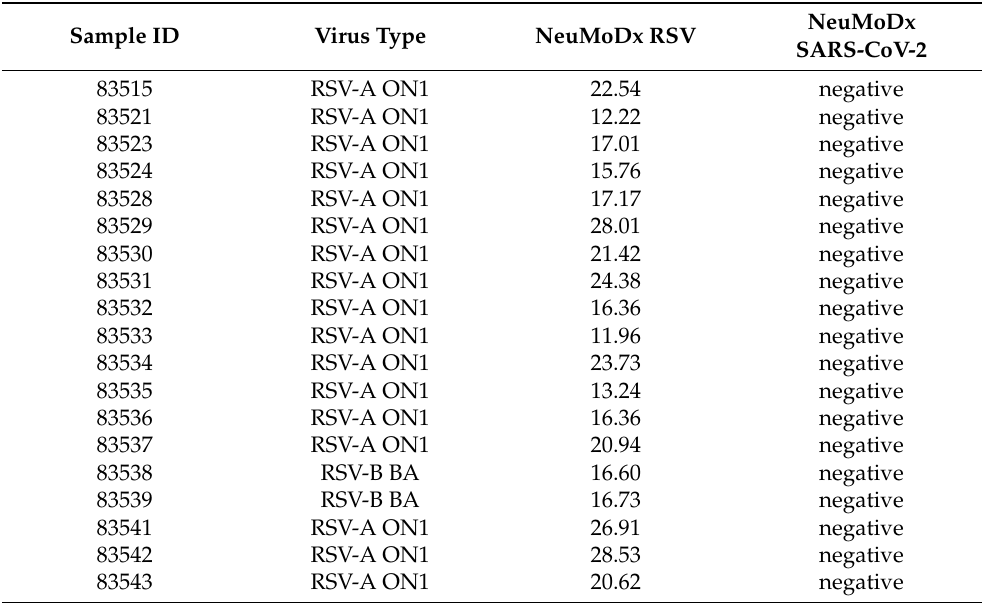
Figure 1. Correlation plots between influenza A RT ‐ PCR and NeuMoDx Flu A results. Forty-three out of 46 RSV positive samples were positive by the NeuMoDx Flu A- B/RSV/SARS-CoV-2 assay, including one sample (83547) that resulted positive for both RSV and SARS-CoV-2 (Table 2).This co-infection was previously confirmed by the FilmArray respiratory panel (Biofire Diagnostics) [7].Using as gold standard the RT-nested PCR, the specificity and the sensitivity for RSV of the assay was 100% and 93.47%, respectively, whereas, the positive predictive value was 100% and the negative predictive value was 92.10%. The discordant three RSV samples that resulted negative by the NeuMoDx Flu A-B/RSV/SARS-CoV-2 Assay were also negative in the RSV typing PCR, being positive only in the first RSV diagnostic PCR, suggesting that the viral load was very low. Table 2. RSV RT-nested PCR positive samples tested on the NeuMoDx Flu A-B/RSV/SARS-CoV-2 Vantage Assay ( n =